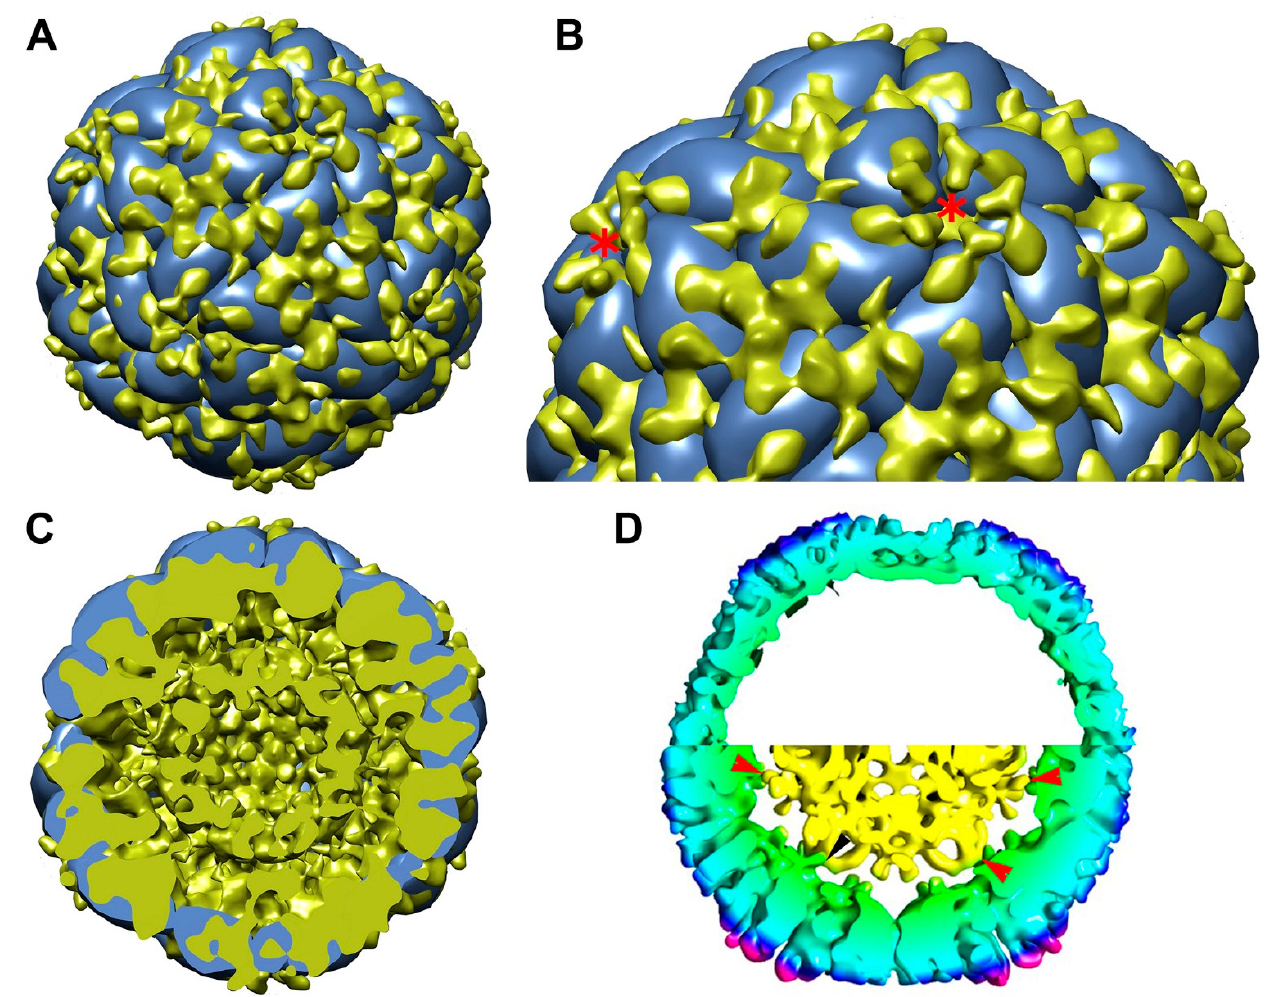
Figure 5. Superimposition of the iso-surface maps ( A , B ), half particle view ( C ), and the comparative mid-sections between the empty and genome-filled IHHNV-VLPs ( D ). Note that most capsid changes were observed in the vicinity of five-fold axes exteriorly (asterisks) and the protruding “nodular” structures interiorly (arrowheads), presumably representing the interaction points between the encapsulated genome and capsid, which would likely lead to inward thickening of capsid structure.